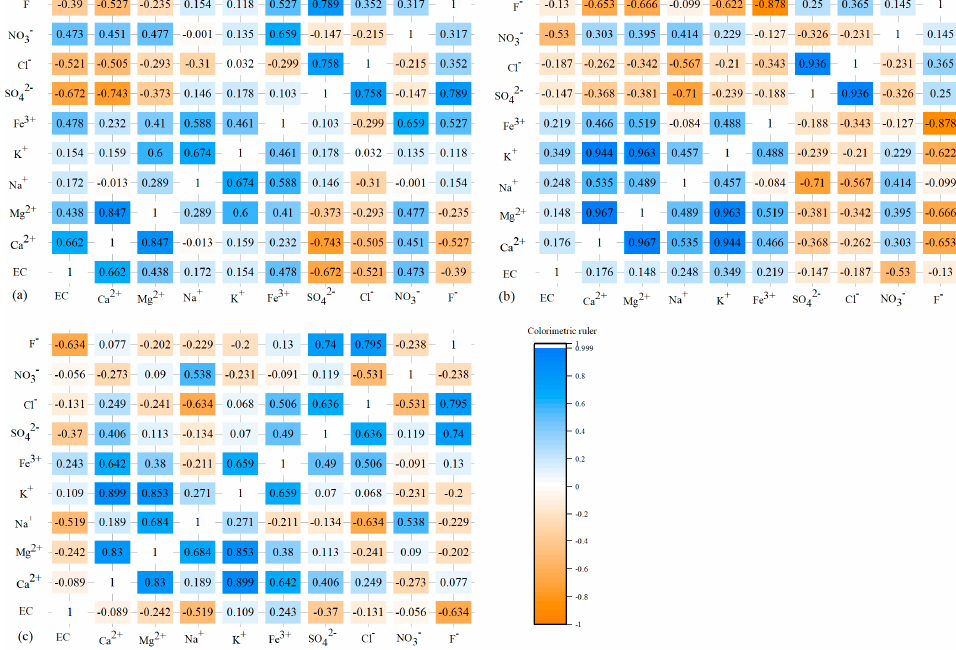
Figure 10. EC and ions correlations plots of FGK1, FGK2, and FGK3 immersion solutions.